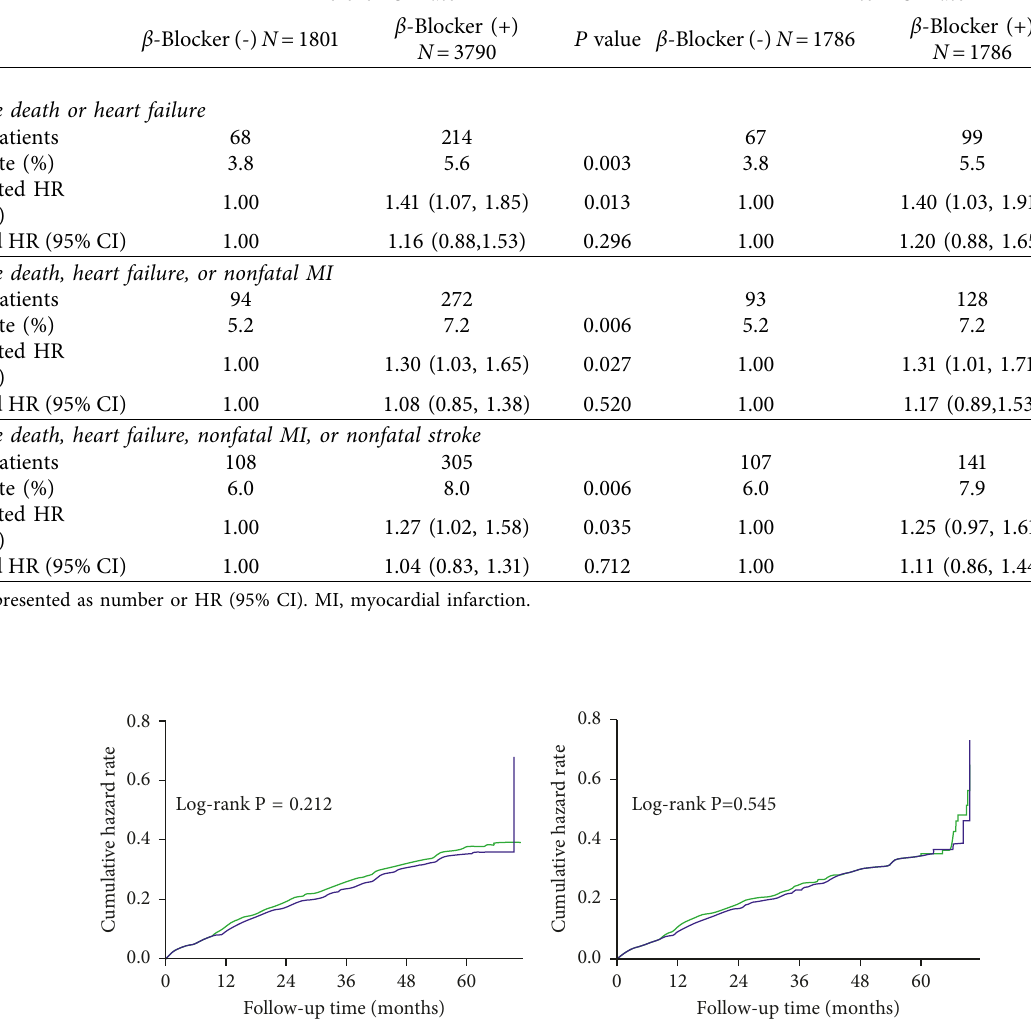
Table 4: Secondary endpoints in patients with UAP in the β -blocker and no β -blocker groups. Before PS match